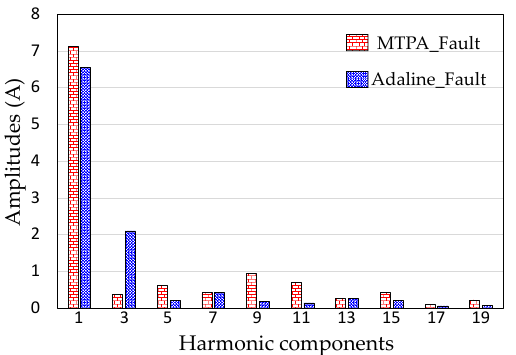
Figure 8. (Numerical result) Harmonic spectrum of phase- B current with the RFOC scheme using MTPA_Fault (Stage 3), and the proposed scheme using Adaline_Fault (Stage 4), when phase A is opened at 300 rpm. Table 5. Comparisons between stage 3 (MTPA_Fault) and stage 4 (Adaline_Fault) at 300 rpm in terms of copper losses when phase A is